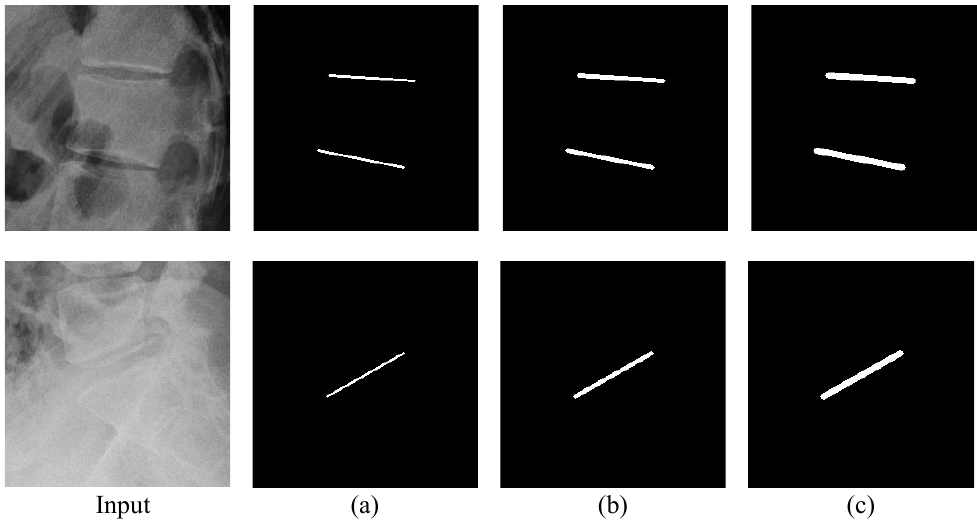
Figure 14. Example of the ground truth of PAFs by width: ( a ) 2 pixels, ( b ) 4 pixels, and ( c ) 6 pixels. Table 6. Performance according to the width of the ground truth of PAFs. The lowest value for each column in distance error (D) is marked in bold and underlined in relative distance error